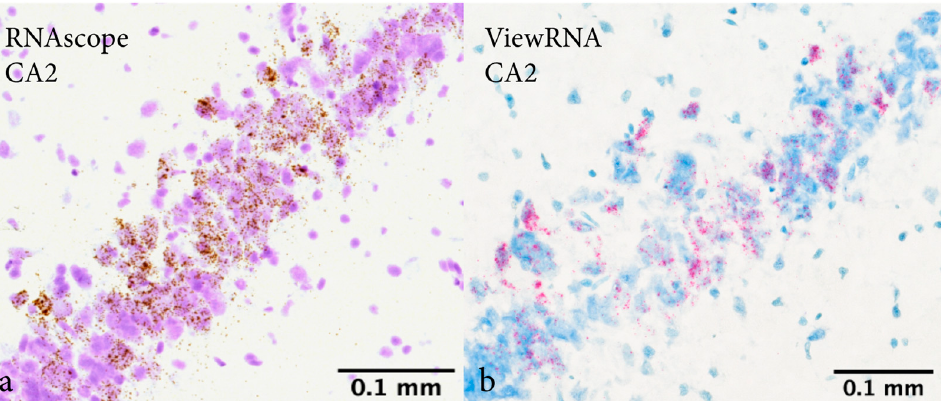
Figure 1. Representative images from ipsilateral subregion CA2 using RNAscope and ViewRNA. Images captured at 20× magnification from the same female rat subjected to penetrating traumatic brain injury and a survival time of 3 days. Captured at Bregma: − 3.84 mm. Image ( a ) shows CYP1B1 mRNA marked in brown (RNAscope) and a cresyl violet counterstaining. Image ( b ) shows CYP1B1 mRNA marked in red (ViewRNA) and a methyl green counterstain. Expression was greatest in CA2 irrespective of sex, intervention and survival time using both RNAscope ( a ) and ViewRNA ( b ). Abbreviations: CA2: Cornu Ammonis 2.